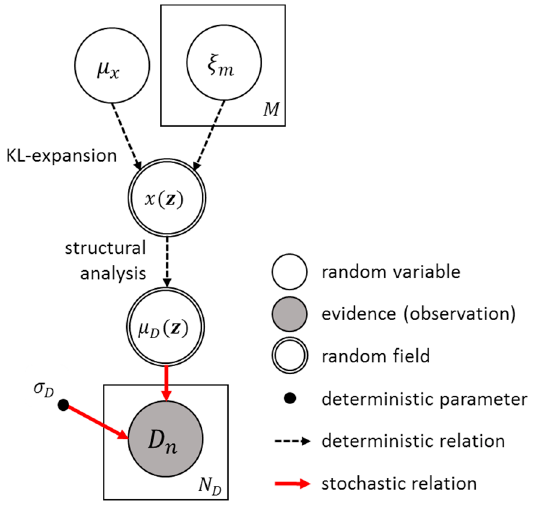
Figure 2. Graphical representation of the measurement model used for Bayesian inversion.